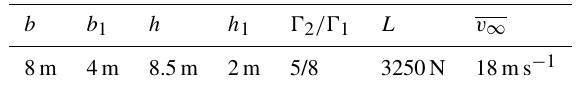
Table A1. Model parameters of the LEI V3 kite for lifting-line the- ory.